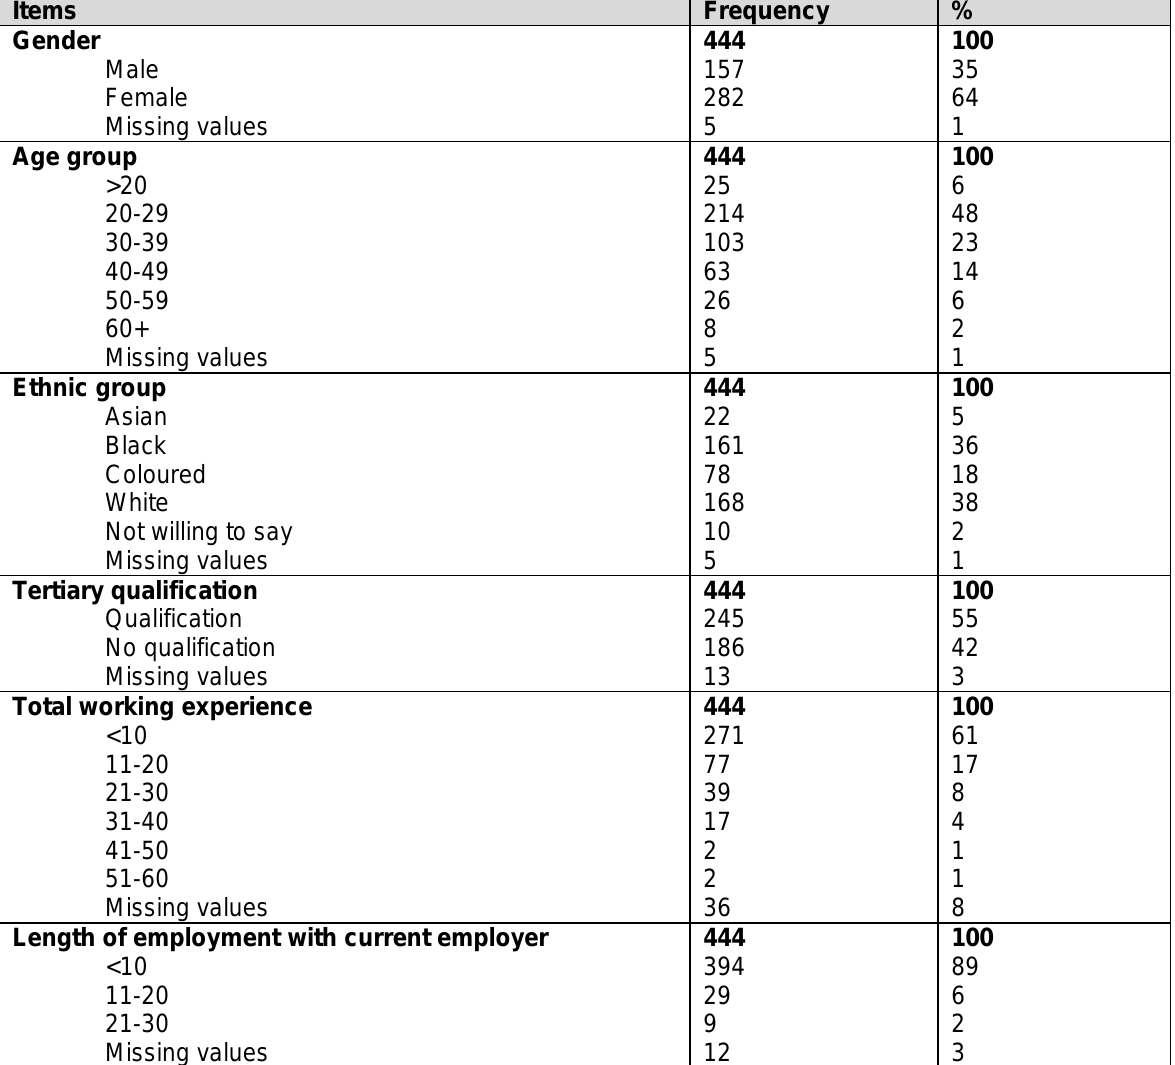
Table 2: Biographical data of